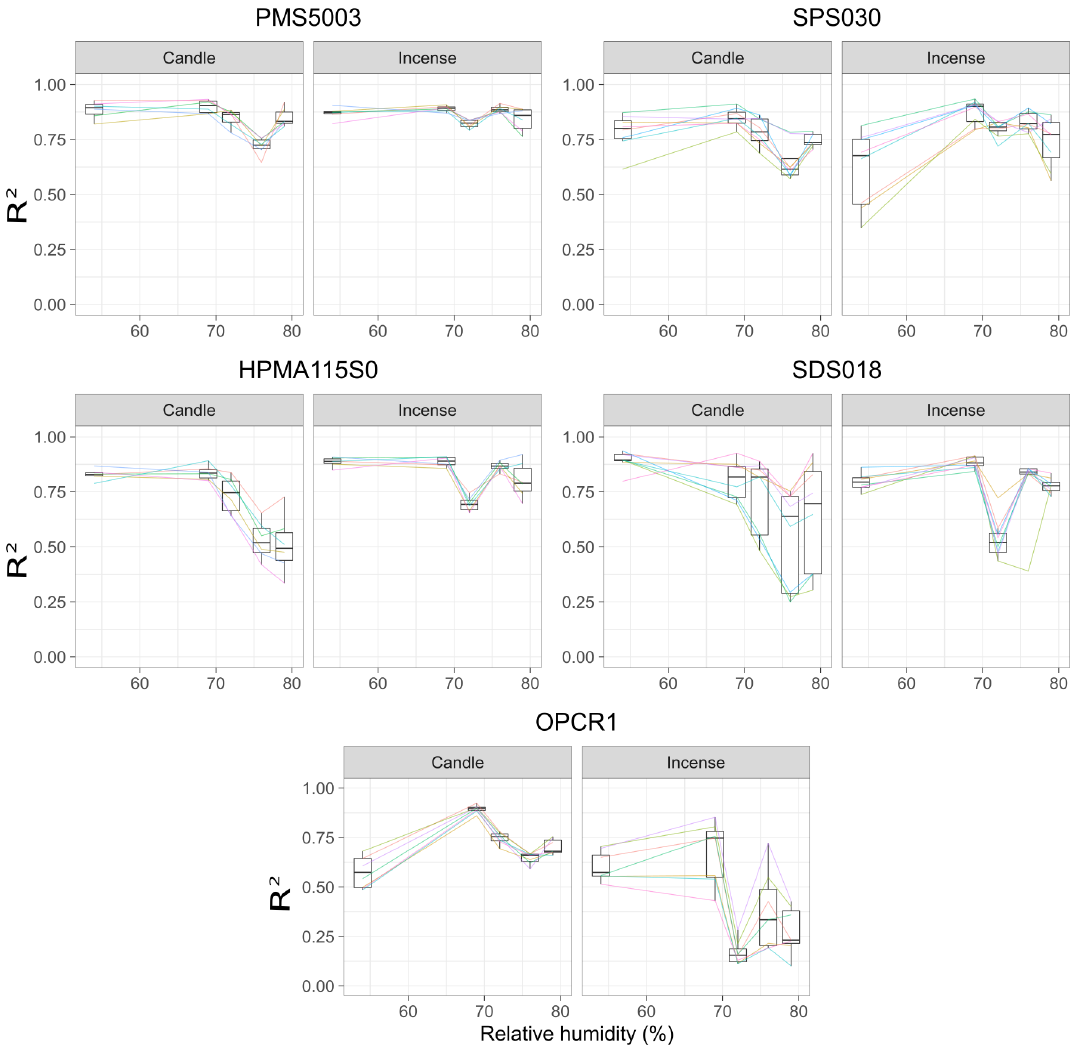
Figure 6. R 2 of the linear regression between the readings of the sensors and the DustTrak for different level of relative humidity (each level of relative humidity corresponds to experiments 1 to 5), for candle and incense generated concentrations of PM 2.5 (peaks and stable concentrations not differentiated). For each graph, the colours correspond to the sensors of the model tested. Only the points with a p -value < 0.05have been considered. The box and whisker plot horizontal lines represent, from bottom to top, the lower quartile, the median and the upper quartile. The vertical lines are drawn to the smallest and the largest data point that fall within 1.5 times the interquartile range below the lower quartile and above the upper quartile respectively. Values outside these range are considered as